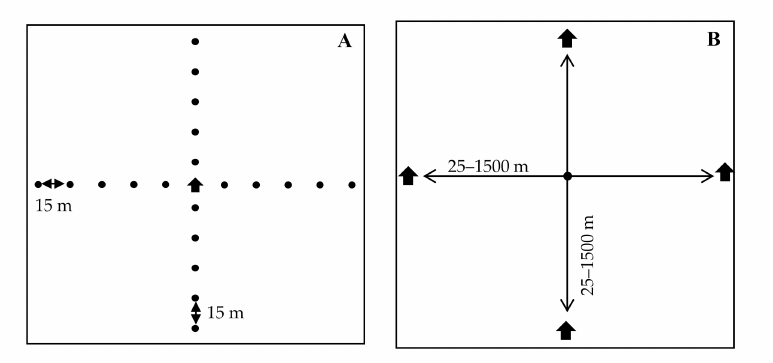
Figure 1. Experimental plot layout for ( A ) Male moth release point, plume reach study and ( B ) Pheromone-baited trap, absolute density